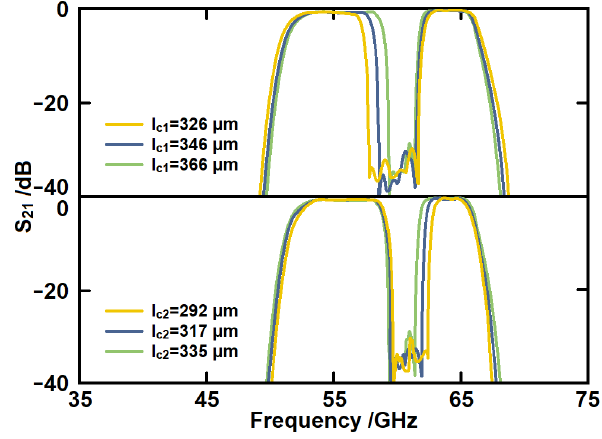
Figure 16. The simulated S 21 of the proposed filter with different sizes of CSRRs.